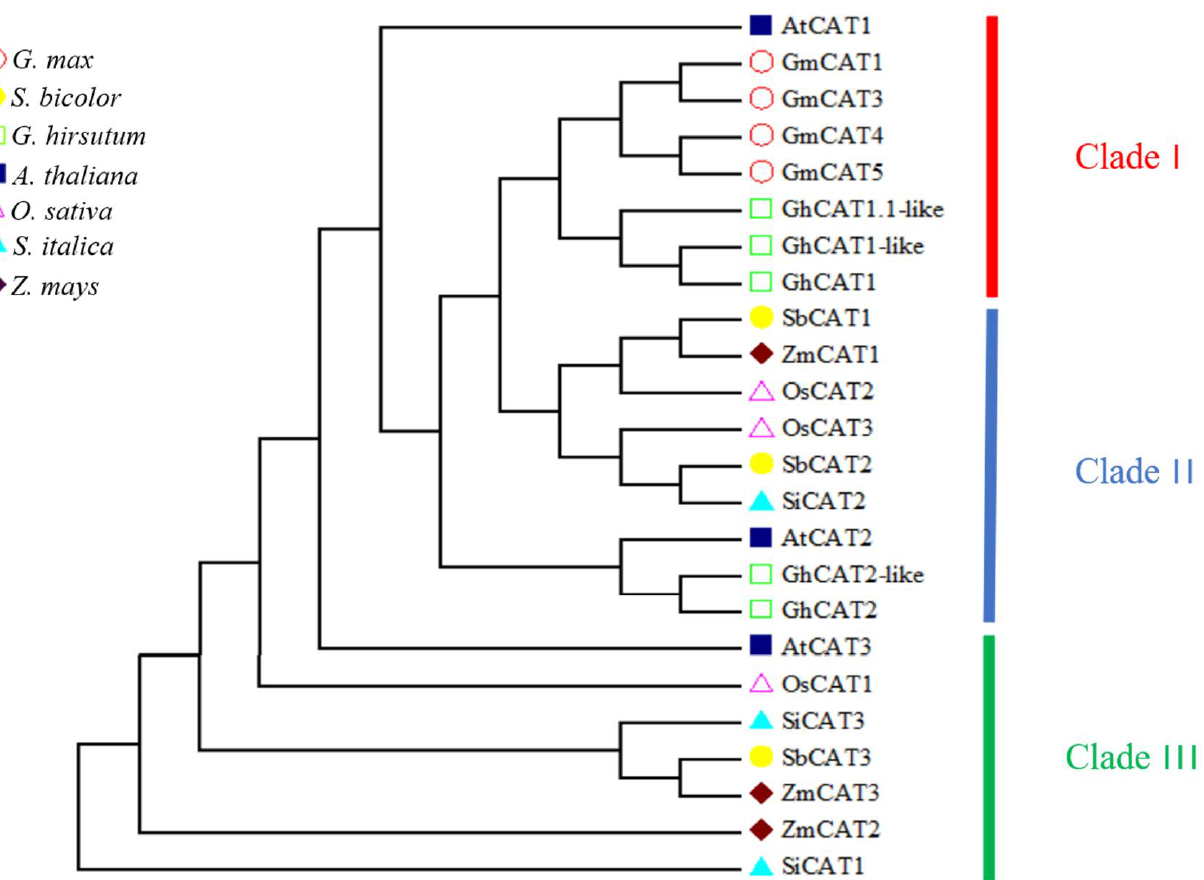
Figure 2. Phylogenetic relationship and architecture of 24 CAT proteins. According to the phyloge- netic relationships, the CAT genes from seven species were clustered into three groups (Clade I−III).